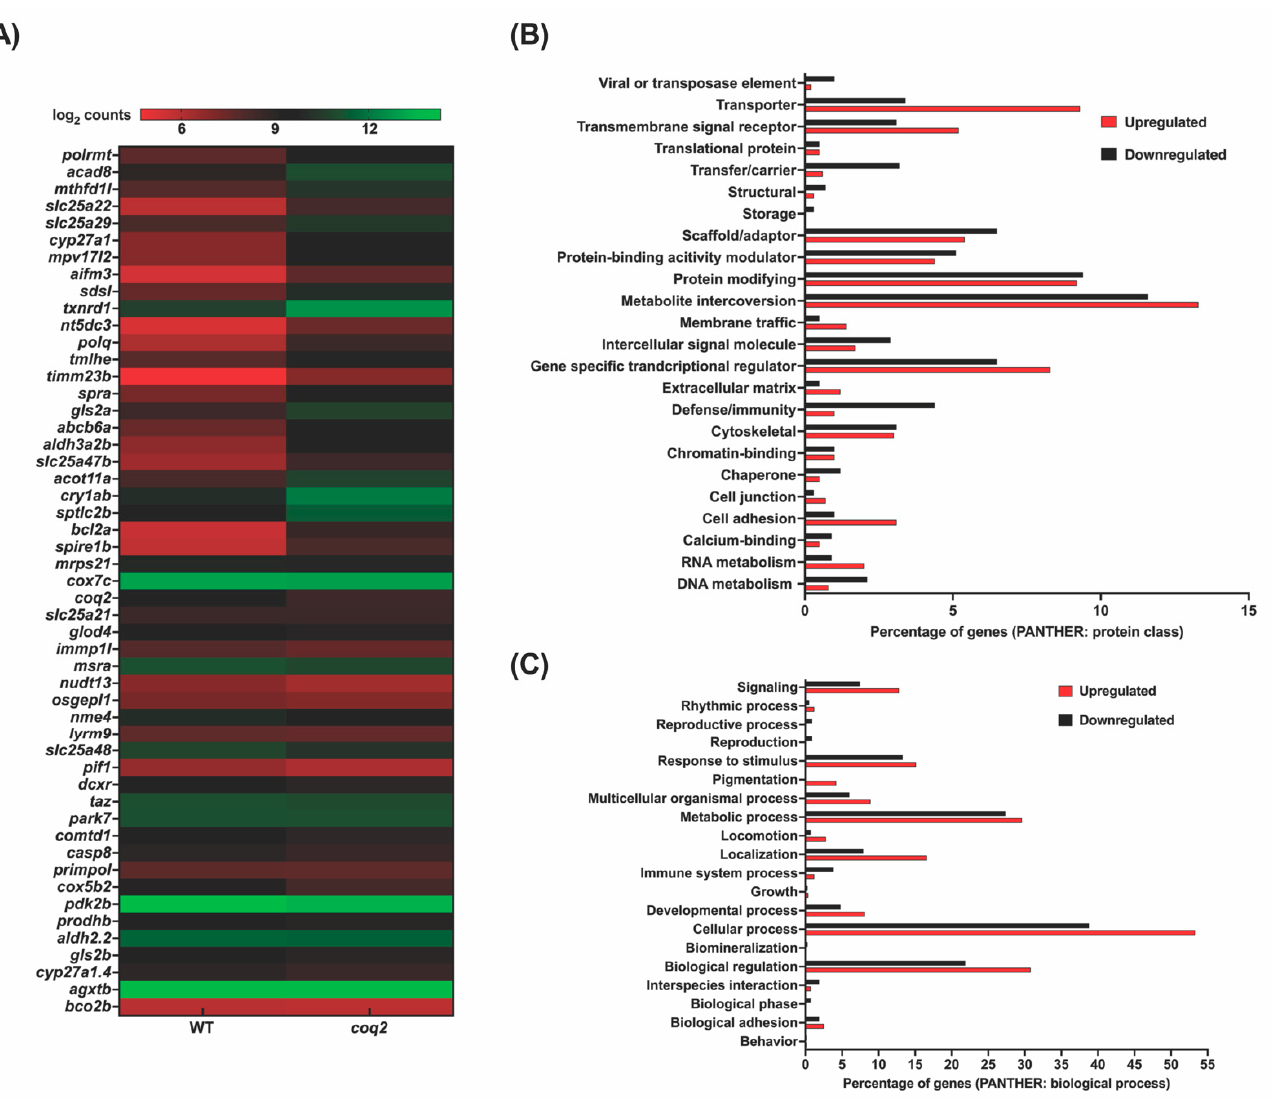
Figure 4. RNAseq analysis of coq2 mutants: ( A ) : Heat map visualization of expression of zebrafish orthologs for human MitoCarta genes. The gradient color scale represents the log 2 CPM value obtained for each of the zebrafish mitochondrial orthologs in the two datasets. ( B , C ): PANTHER classification for all the differentially expressed genes in the homozygous mutant according to protein class ( B ) and biological process ( C ). Each histogram represents the percentage of genes falling in each of the categories.